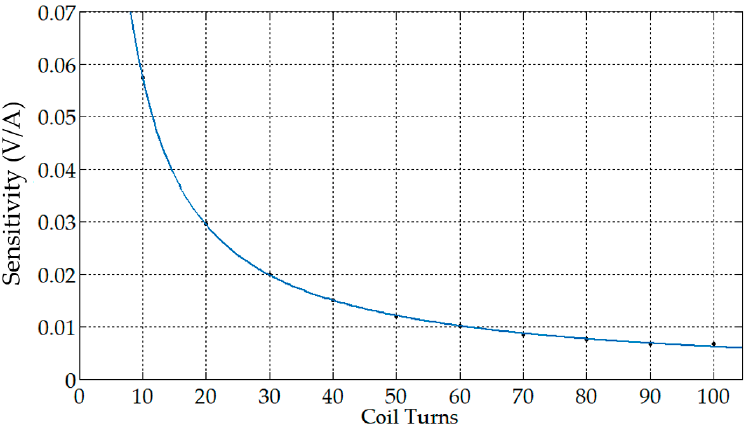
Figure 10. The relationship between the number of turns and sensitivity.